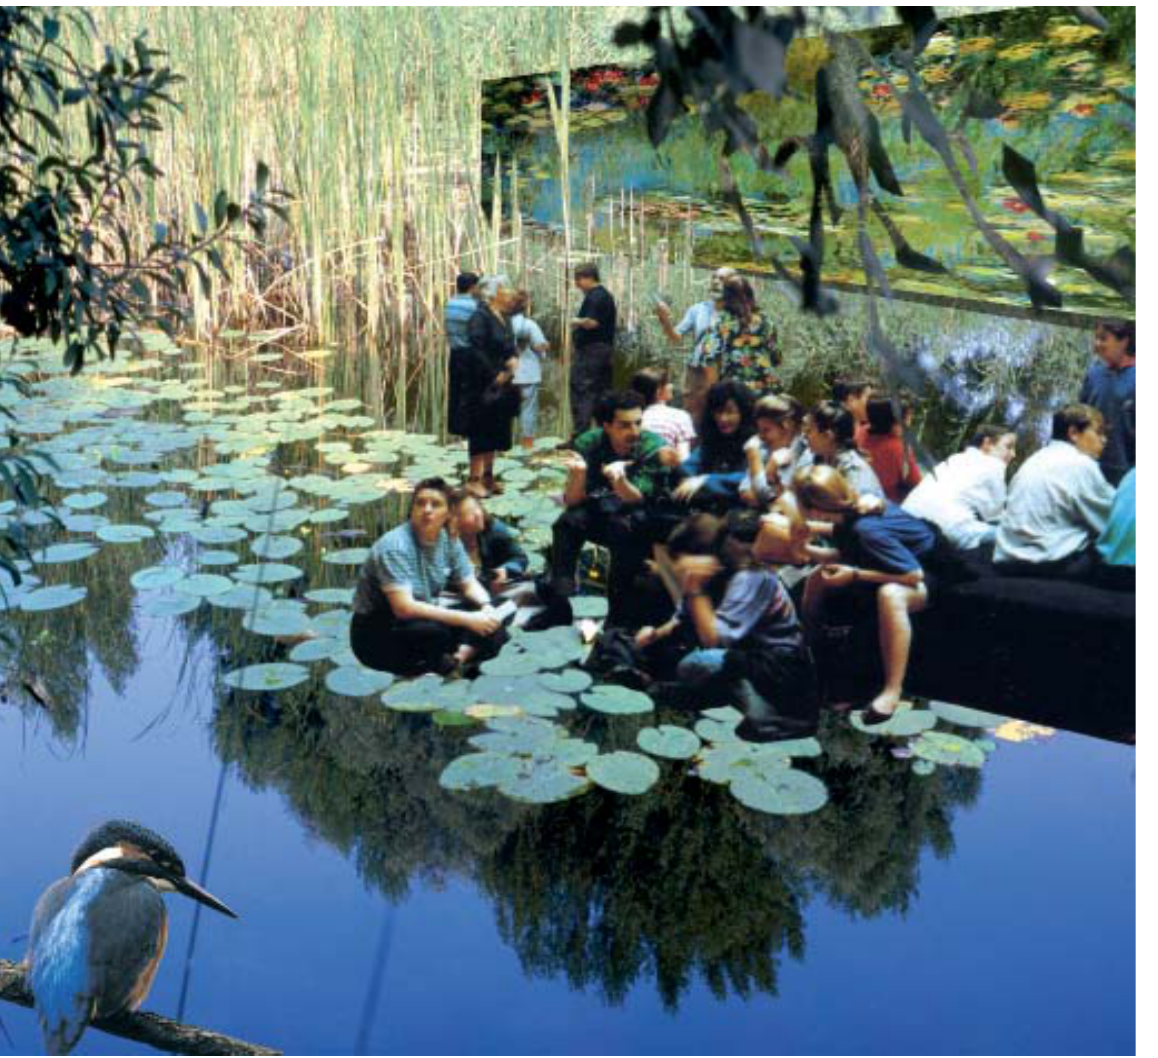
Figure 5. Future Landscapes: “Natura 2030 landscape” (Artner et al.